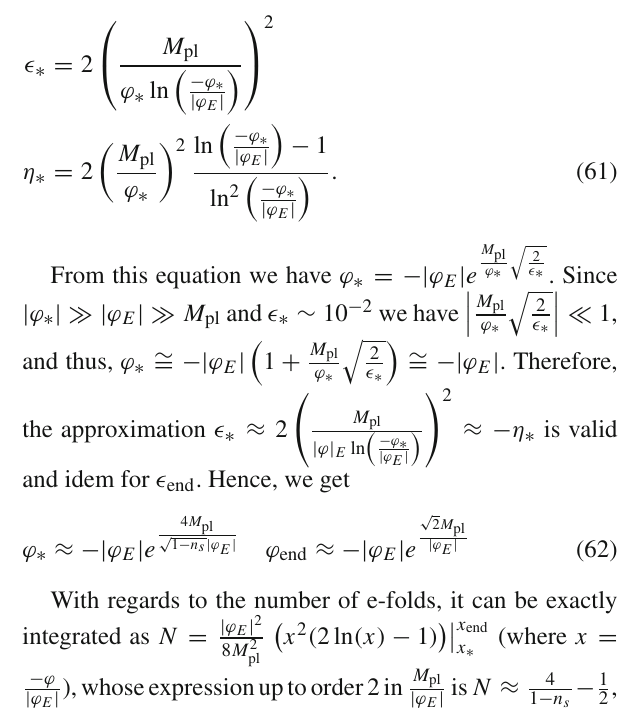
) (left) for some orbits, with the slow-roll one represented in black. Evolution of H / M Fig. 10 Phase portrait in the plane (ϕ/ M pl , ˙ ϕ/ M 2 pl function of the time t × M pl (right) for the same orbits represented in the phase portrait H 2 T R ∼ 3 × 10 − 2